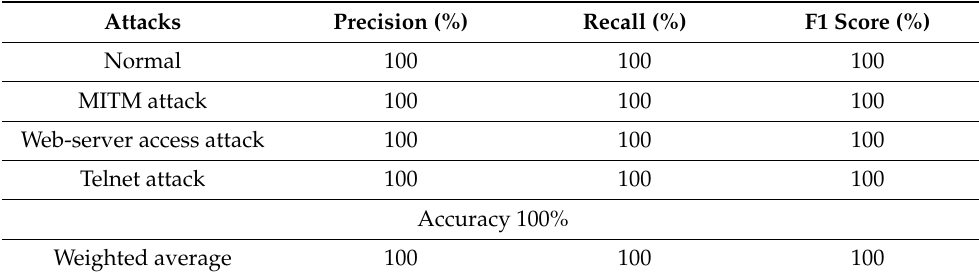
Table 11. Results of the decision tree using the multiclass classification dataset.